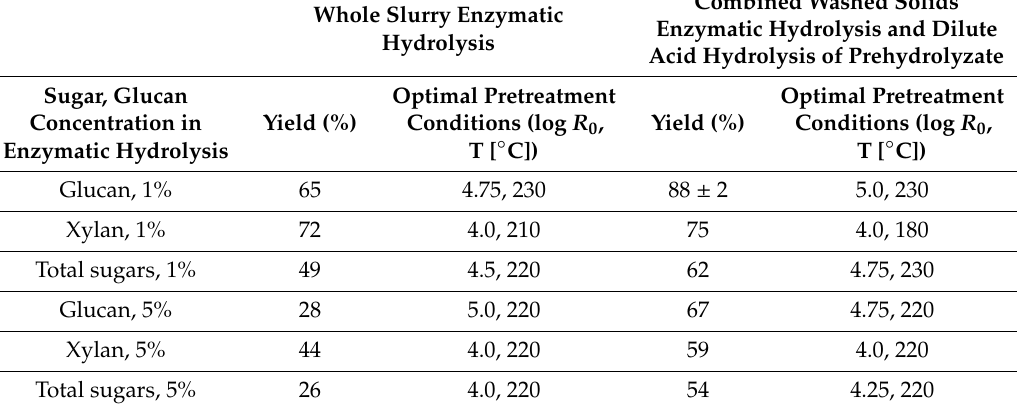
Table 2. Summary of the maximal sugar yields after steam explosion pretreatment and enzymatic hydrolysis. Shown are the maximal sugar yields after steam explosion pretreatment and enzymatic hydrolysis of washed solids or whole biomass slurry at two di ff erent glucan